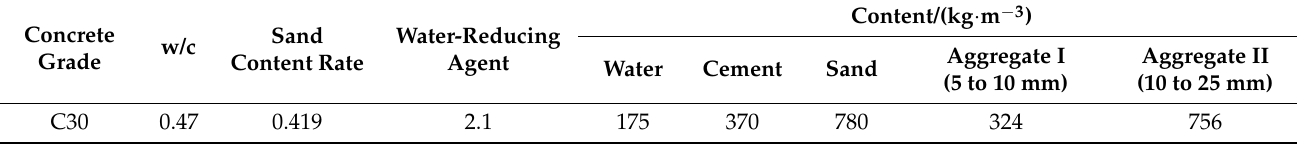
Table 1. Mix proportion of concrete.